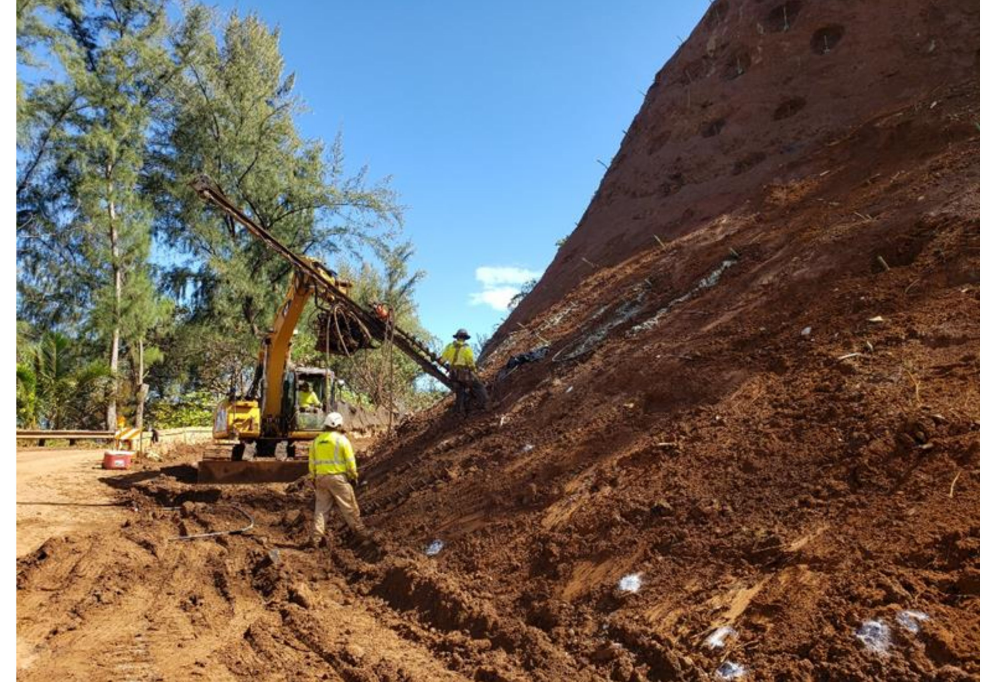
Figure 4. Landslide stabilization with metal soil nails. Source: Authors.